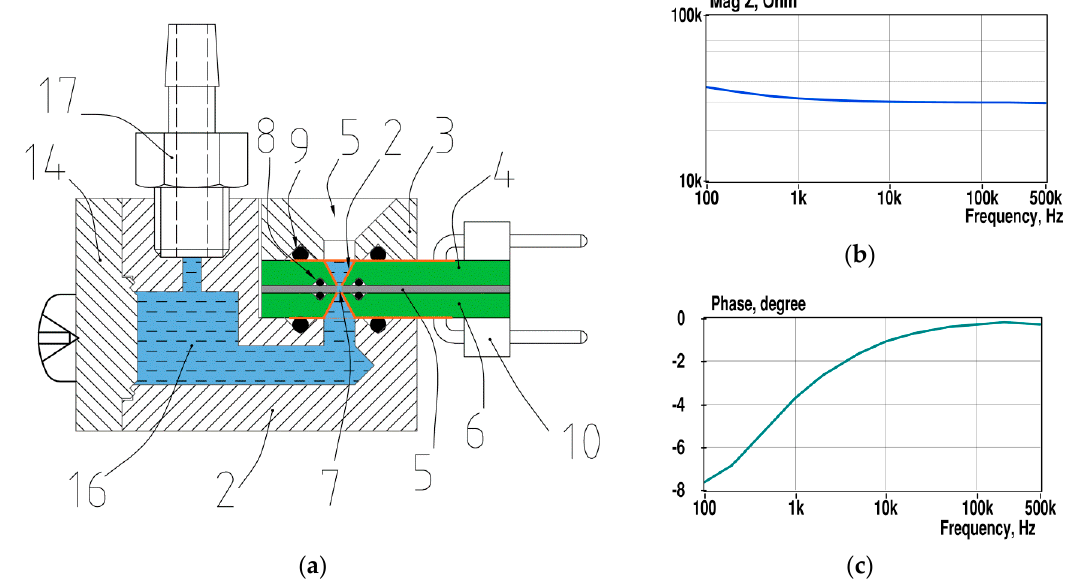
Figure 5. Cross section view ( a ) of the sensor adapted from patent application (given in the patent section) and the measured spectra ( b ) and ( c ) of the PBS solution with a conductivity of 1.3 S/m. Gold-plated electrodes (2) are formed by two PCBs (4 and 6), and a miniature measurement chamber (7) with a thin dielectric layer (5.) The height of the conical electrodes is 1.6 mm, and the diameter of their base is 0.8 mm. The height of the measurement chamber is 0.5 mm and its diameter is 0.1 mm.